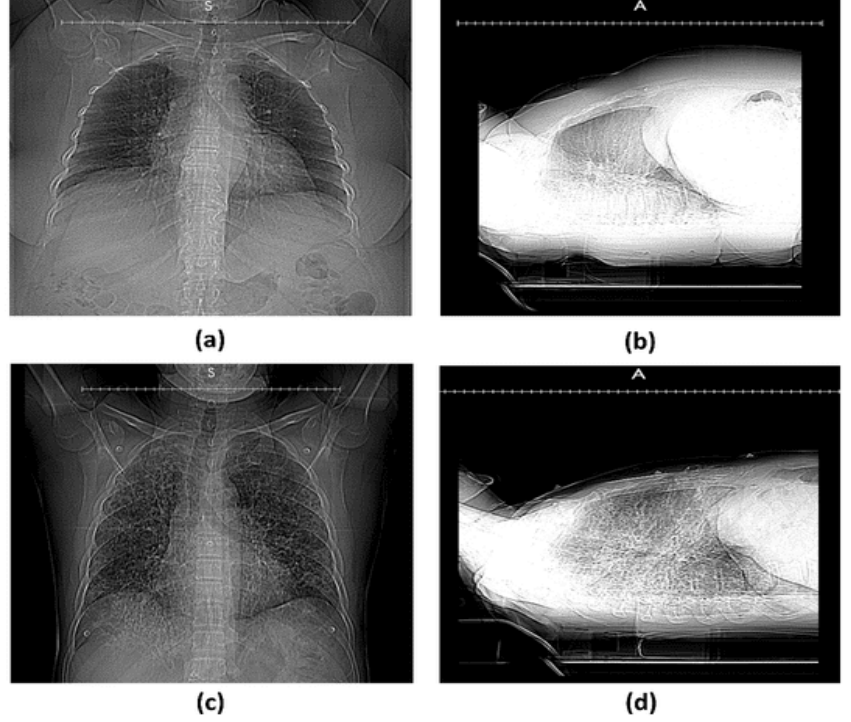
Figure 8. Image examination result (computed tomography) of two study patients: ( a , b ) represent the frontal and lateral images, respectively, of a patient with moderate pulmonary impairment, and the main pulmonary findings were opacities in ground glass predominantly amorphous and rounded, with bilateral distribution and diffusely affecting several lobes; ( c , d ) represent the frontal and lateral images, respectively, of a patient with severe pulmonary involvement, with ground-glass opacities, intra/interlobular septal thickening (mosaic paving), foci of consolidation of the lung as pulmonary findings. Air space, sometimes with perilobular morphology, suggestive of organizing pneumonia, with bilateral distribution.